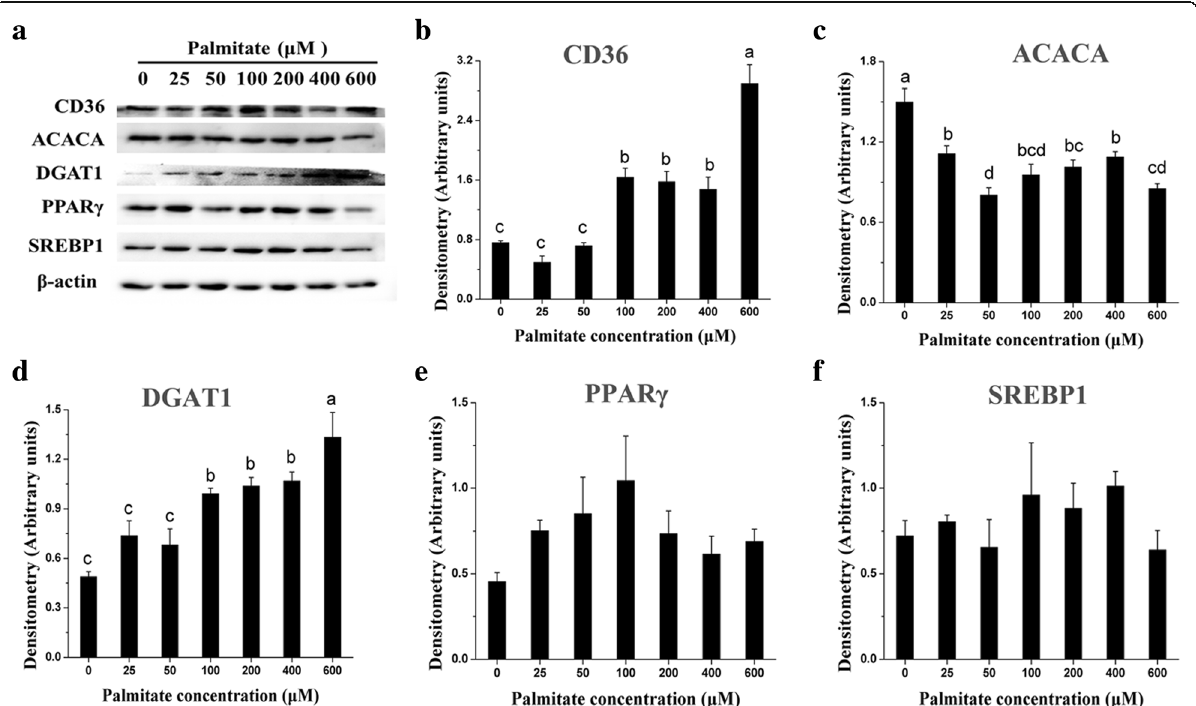
Fig. 4 Effect of palmitate on the expression of proteins involved in lipid synthesis in pMECs. pMECs were incubated for 24 h with different concentrations of palmitate (0 (control), 25, 50, 100, 200, 400, and 600 μ M). a Representative protein bands of CD36, ACACA, DGAT1, PPAR γ , and SREBP1. Bar graph of protein expression level relative to β -actin, including CD36 ( b ), ACACA ( c ), DGAT1 ( d ), PPAR γ ( e ), and SREBP1 ( f ). The data are expressed as the mean ± SEM ( n = 3). Different letters indicate statistical significance between different concentrations of palmitate treatment groups ( p <